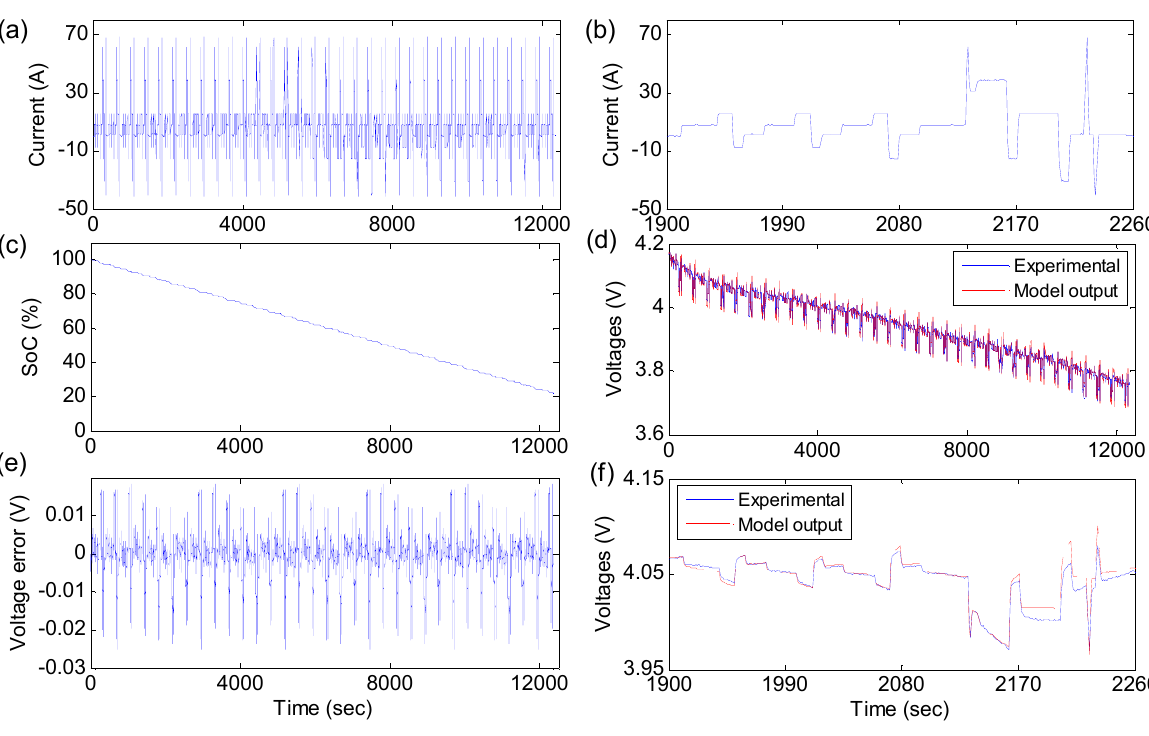
Figure 7. Model validation under UDC test. ( a ) Input current profile; ( b ) Amplified current of one driving cycle; ( c ) SoC trajectory; ( d ) Comparison of experimental and model output voltages; ( e ) Voltage error; ( f ) Amplified experimental and model output voltage.